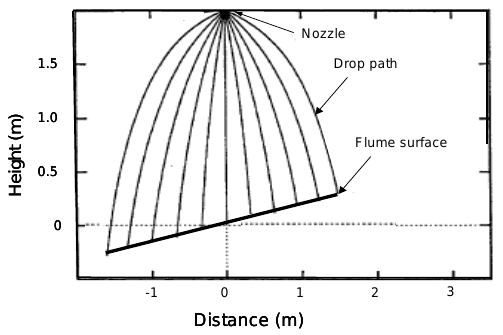
Fig. 7. Two-dimensional drop paths of a 1-mm drop ejected in dif- ferent directions with a velocity of 5ms − 1 , in still-air. The slope of Fig. 7 - Two-dimensional drop paths of a 1-mm drop ejected in different directions with a velocity of 5 3 the receiving plane is 10% (adapted from de Lima et al., m s -1 , in still air. The slope of the receiving plane is 10% (adapted from de Lima et al., 2002). 4